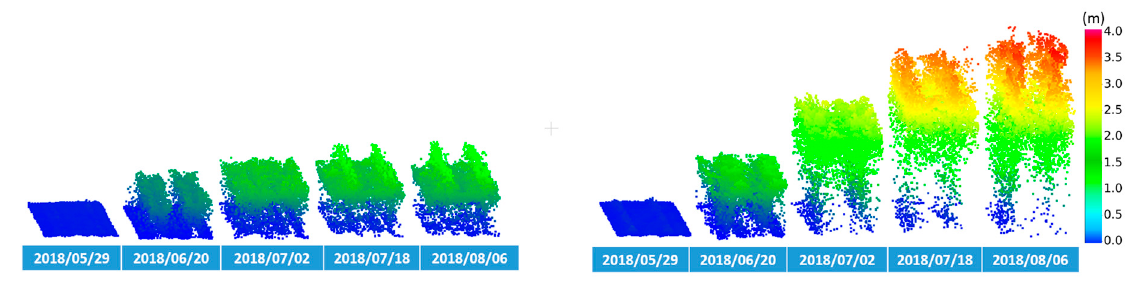
Figure 8. Point cloud data for rows two and three of two plots of the HyCal-18 experiment for multiple dates in the 2018 growing season. “341 × 10” and “Trudan Headless” achieve maximum height of 1.4 m and 3.2 m, respectively.